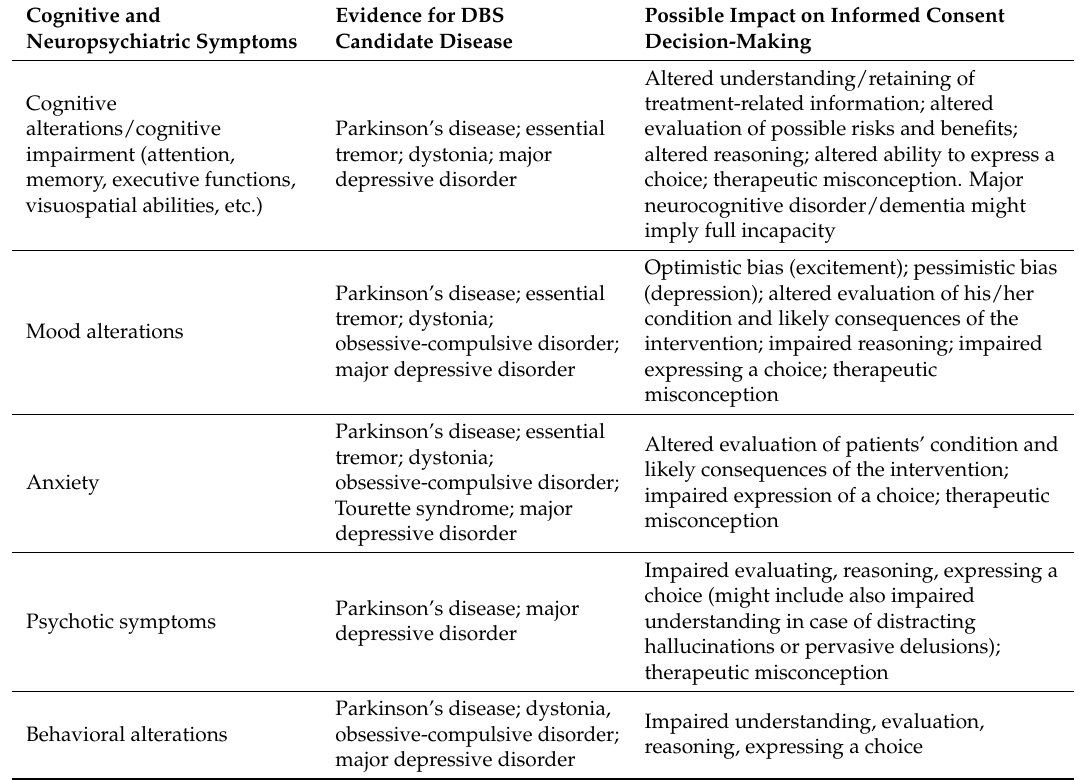
Table 1. Cognitive and neuropsychiatric symptoms of deep brain stimulation (DBS) candidate diseases and their possible impact on neurosurgical treatment and research decision-making